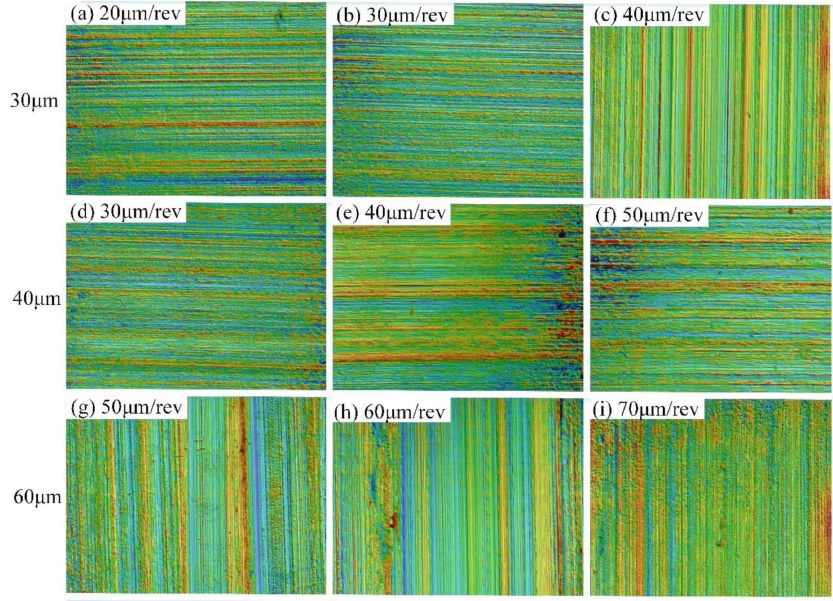
Figure 3. The topography of the machined surface. The grain size of the workpiece is 30 µ m: ( a ) feed rate = 20 µ m/rev, ( b ) feed rate = 30 µ m/rev, ( c ) feed rate = 40 µ m/rev; The grain size of the workpiece is 40 µ m: ( d ) feed rate = 30 µ m/rev, ( e ) feed rate = 40 µ m/rev, ( f ) feed rate = 50 µ